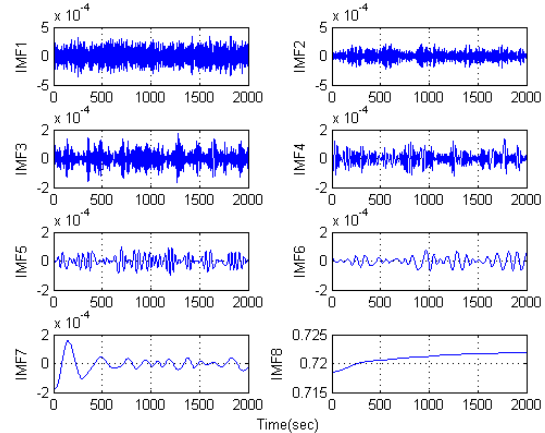
Figure 11. IMFs obtained by the temperature drift signal decomposition of EMD.